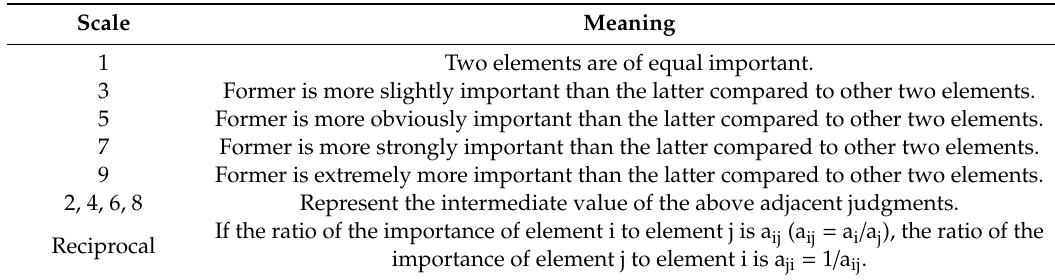
Table 1. Scale reference for indicators.